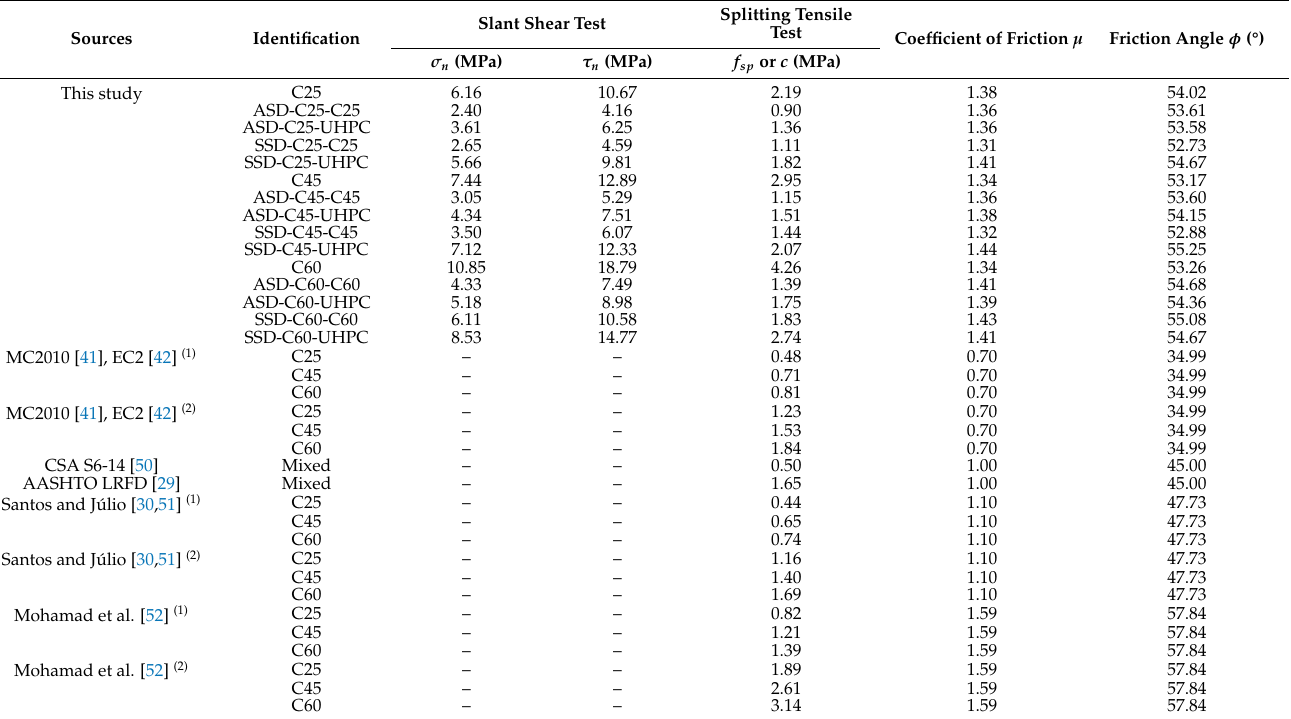
Table 9. Predictive values of the bond strength between